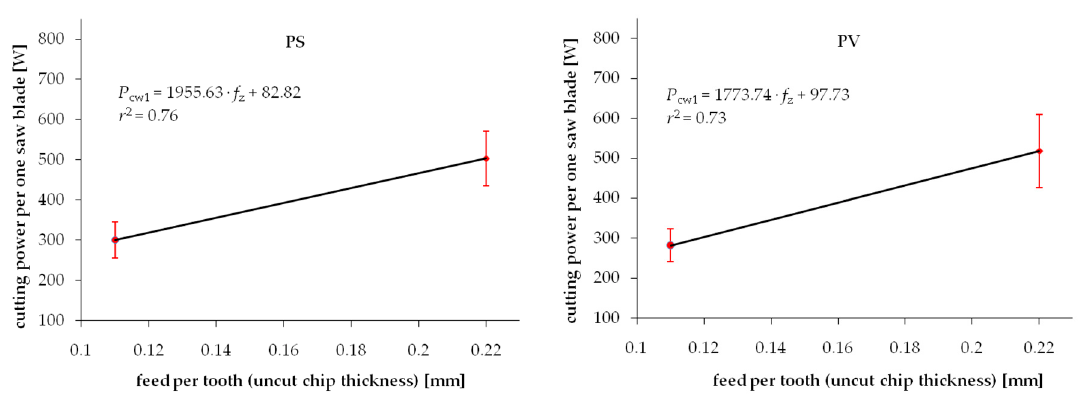
Figure 3. Relation between cutting power per one saw blade and uncut chip thickness when sawing pine wood dried with different methods: PA—air drying, PC—conventional kiln drying, PS—warm heated-steam experimental drying, PV—vacuum kiln drying.